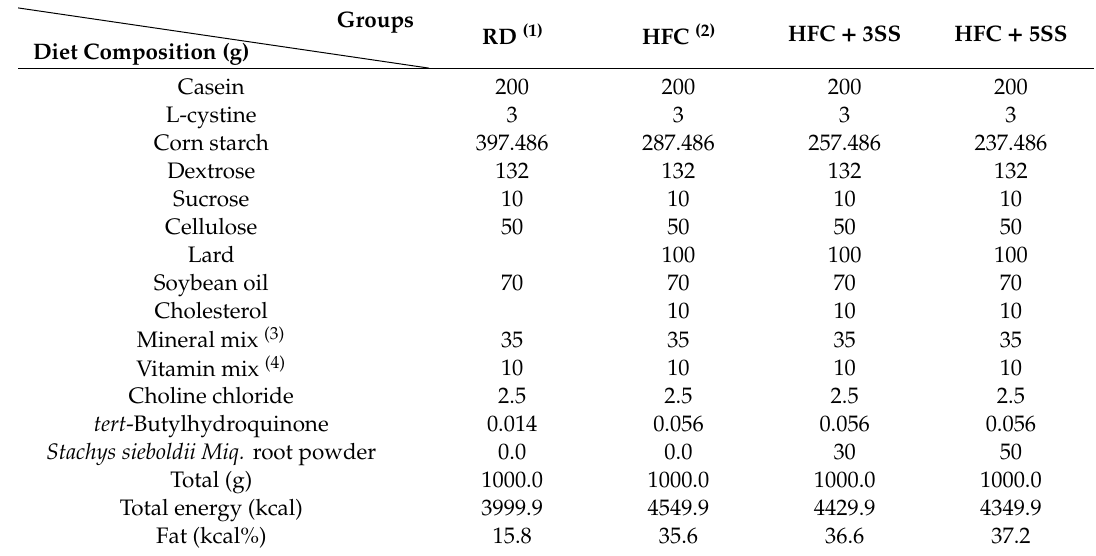
Table 1. Composition of experimental